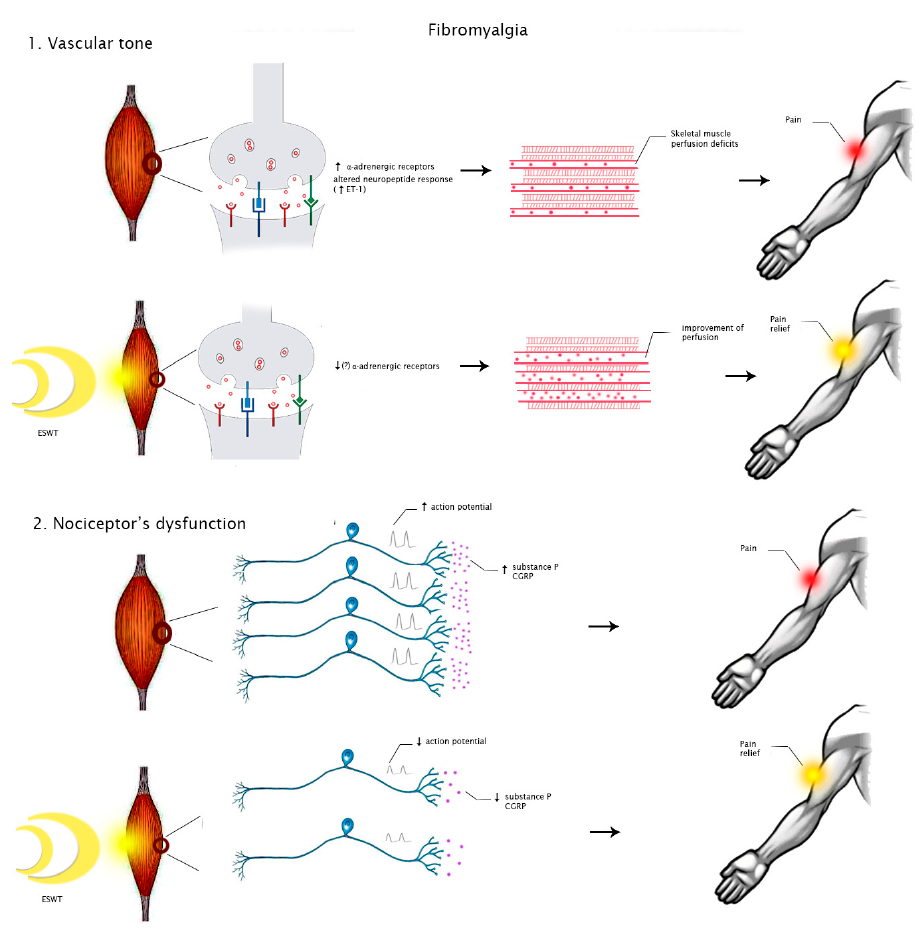
Figure 3. Hypothesized mechanisms of action of ESWT in people with FM. Abbreviations: ET-1, endothelin 1; CGRP, calcitonin gene-related peptide.